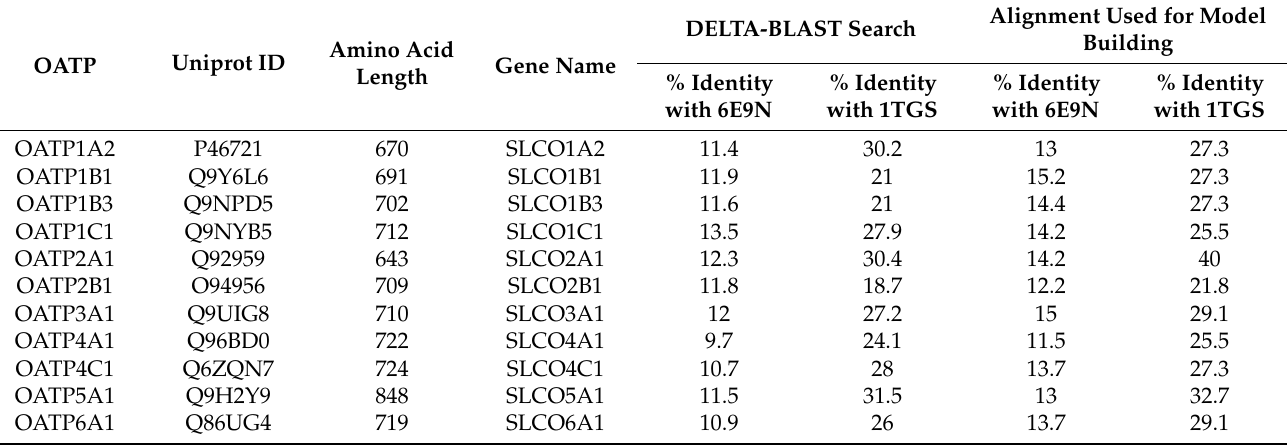
Table 1. Results from the delta blast with percentage identities between the query and template protein